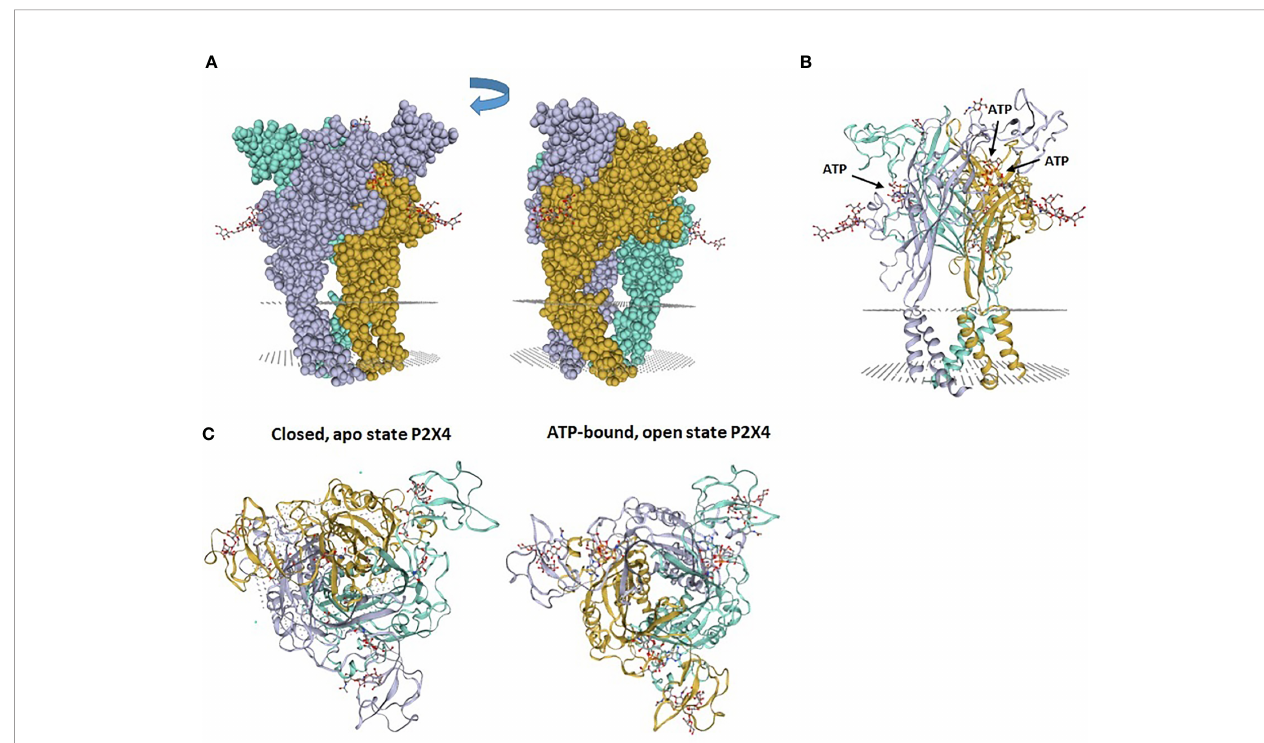
FIGURE 1 | Zebra fi sh P2X4 receptor structure. (A) The P2X4 receptor is composed of 3 “ dolphin ” -like subunits, comprising a body, head, dorsal fi n, right and left fl ippers and tail. Each “ dolphin ” -like subunit is shown in a different color (purple, yellow and blue). (B) Crystal structure of zebra fi sh P2X4 receptor showing 3 subunits (in purple, yellow and blue). Each subunit has transmembrane (TM)1 and TM2 a -helices and long ectodomains. The gray dotted areas in (A, B) indicate the presumptive plasma membrane location in which the receptor is inserted. (C) View from above of the crystal structure of zebra fi sh P2X4 receptor showing a closed, apo state P2X4 receptor and an ATP-bound, open state P2X4 receptor. Images (PDB ID 4DW0 and 4DW1) were obtained from the SWISS-MODEL Repository (10). 4DW0 indicates crystal structure of the ATP-gated P2X4 ion channel in the closed, apo state at 2.9 Angstroms. 4DW1 shows crystal structure of the ATP-gated P2X4 ion channel in the ATP-bound, open state at 2.8